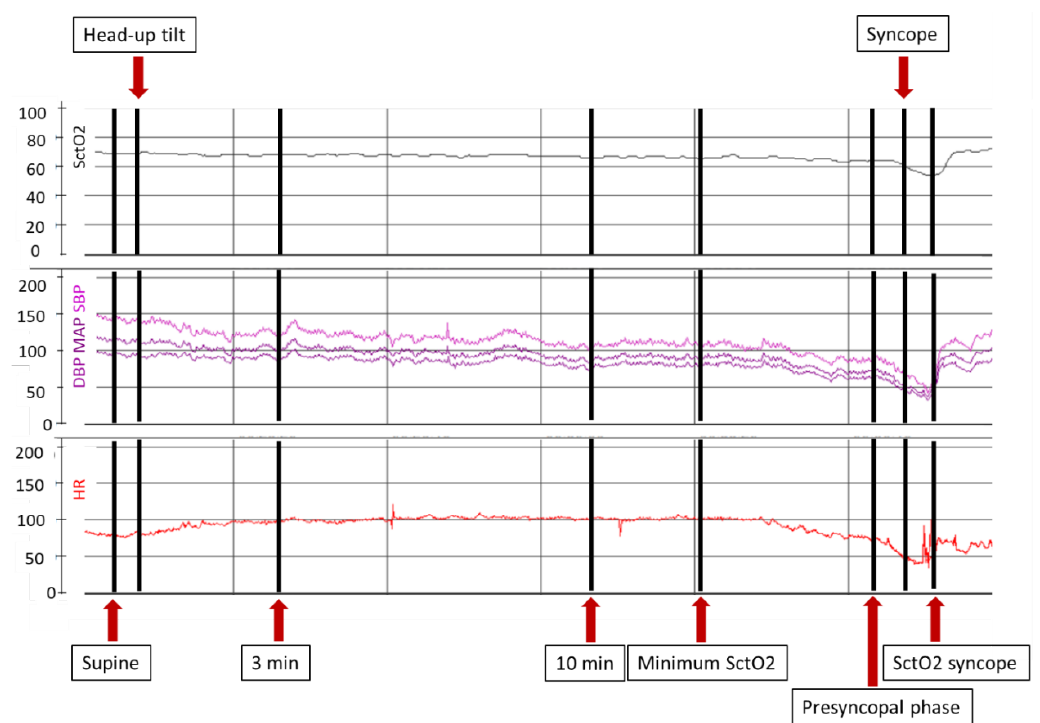
Figure 2. Example of a patient with vasovagal syncope during head-up tilt test. SctO2 values were collected in supine position, after 3 and 10 min of tilt, during lowest measured value before reflex activation (minimum SctO2); 30 s before syncope (presyncopal phase); and lowest measured value during syncope (SctO2 syncope). Abbreviations: DBP = diastolic blood pressure; HR = heart rate; MAP = mean arterial pressure; SBP = systolic blood pressure; SctO2 = cerebral tissue oxygenation. Patients with VVS, OH and negative HUT were divided into three age groups i.e.,